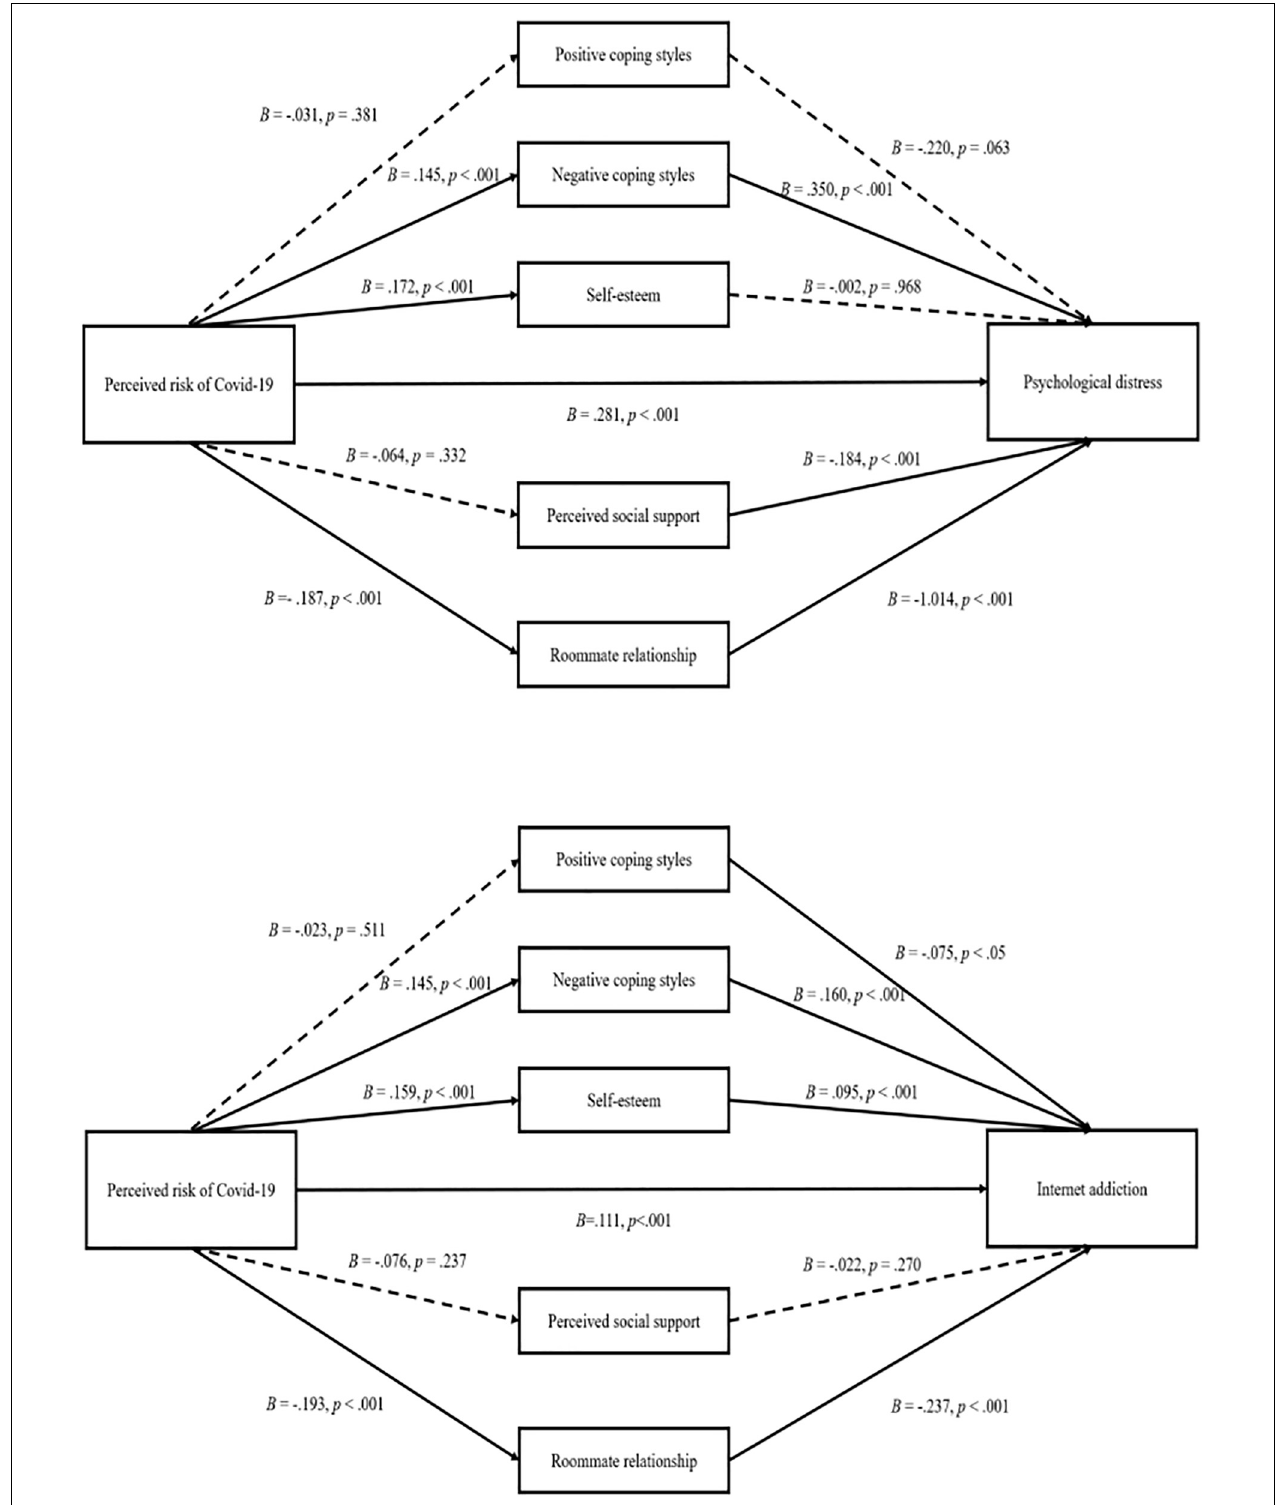
FIGURE 2 | The parallel mediation between the perceived risk of COVID-19, psychological distress, and internet addition.